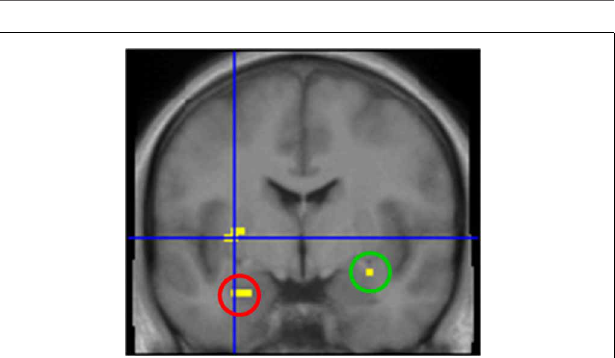
FIGURE 2 | Brain activation after stimulation with odors. Highlighted areas include left insula (cross hair), left amygdala (red circle) and right amygdala/piriform cortex (green circle). Contrast: [AMB + HEN + MIX] vs. CON; y = − 1.